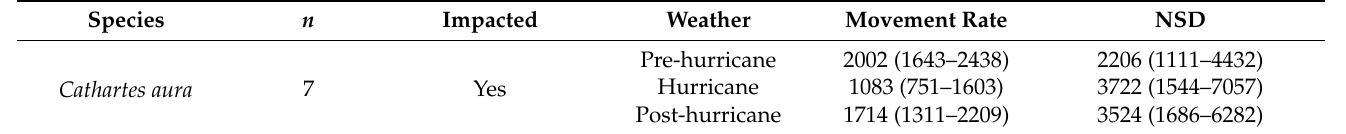
Table 1. Average movement rate (meters/hours) and net-squared displacement (NSD, km 2 ) of black and turkey vultures ( Coragyps atratus and Cathartes aura , respectively) before, during, and after extreme weather events in Mississippi, USA. Numbers in brackets correspond to 95% confidence intervals. n = sample size (# of birds tracked). Impacted = whether birds were directly affected by the event. Species n Impacted Weather Movement Rate NSD Cathartes aura